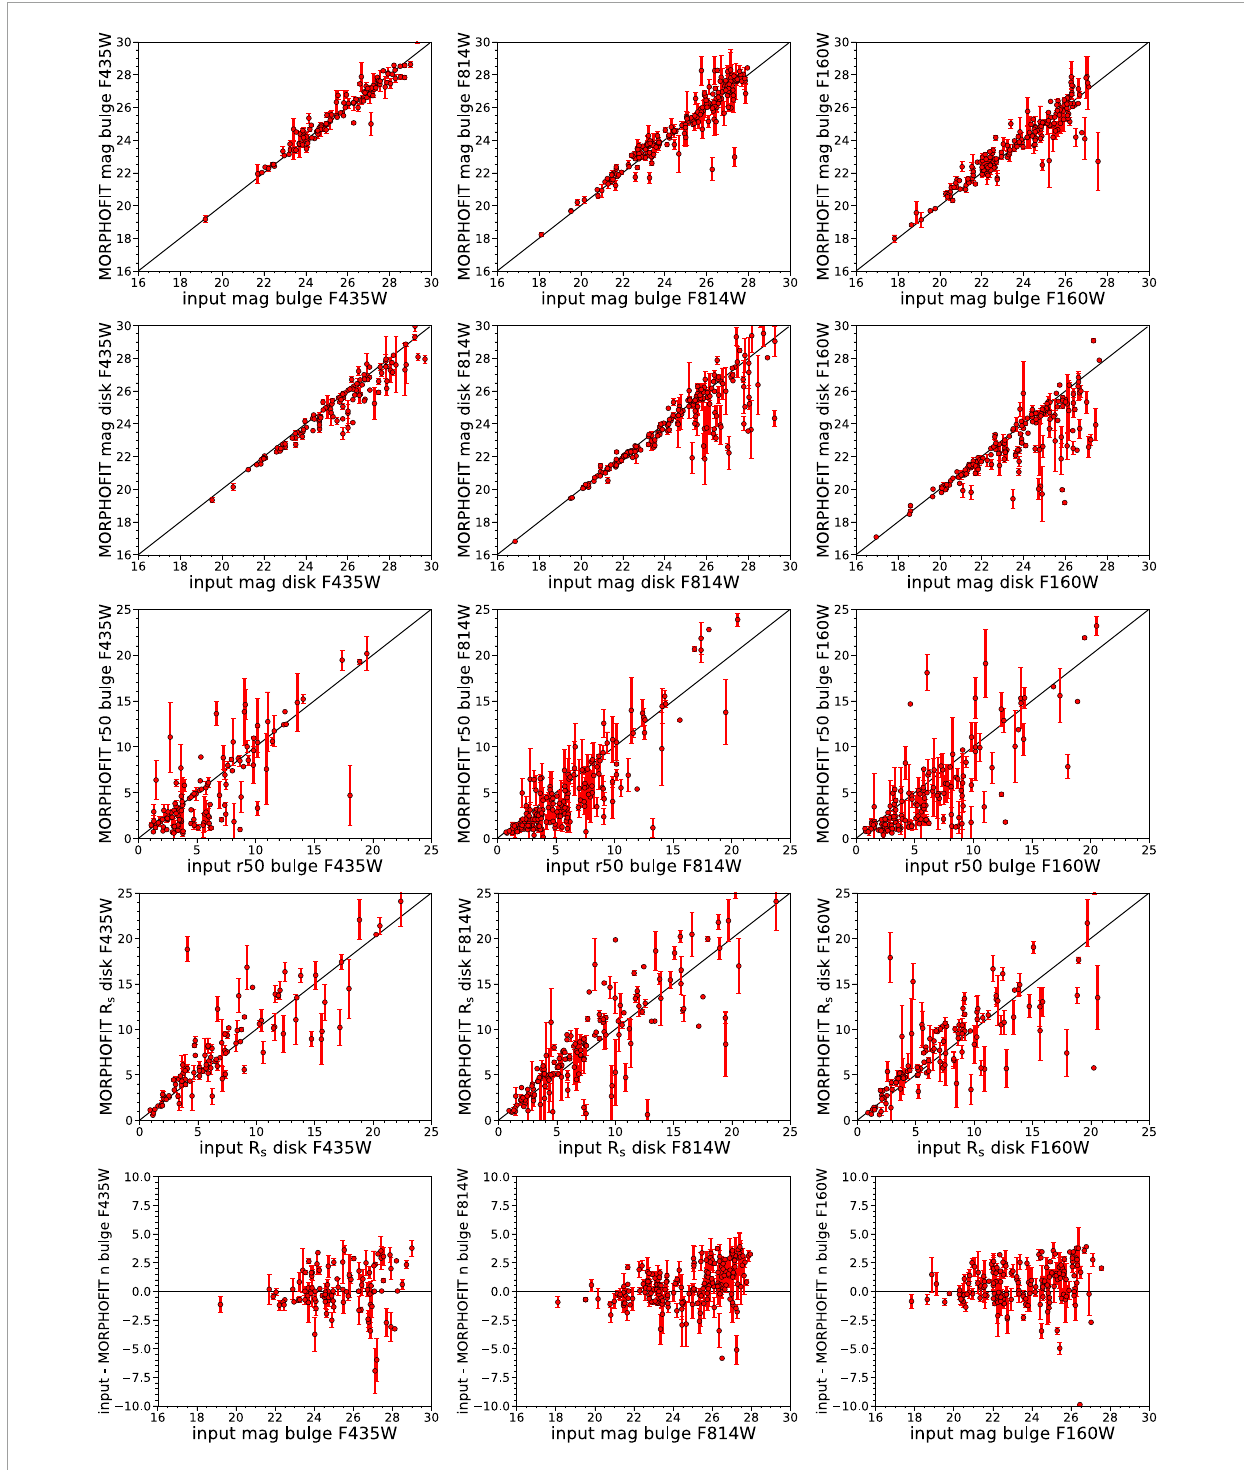
FIGURE 6 The first and second rows of panels show the comparison between the input simulated galaxy magnitudes of bulge (first row) and disk (second row), and the corresponding best-fitting magnitudes from MORPHOFIT . The third and fourth rows of panels show the comparison for the effective radii and the scale lengths. The fifth row shows the deviation of the recovered bulge Sérsic index with respect to the input one. For each row, we only select a sub-sample of the seven wavebands for plot clarity, comparing similar bands for the bulge and disk components. Red points refer to the simulated target galaxies and their neighbouring objects. The black solid line represents the one-to-one relation between the input and the best-fitting